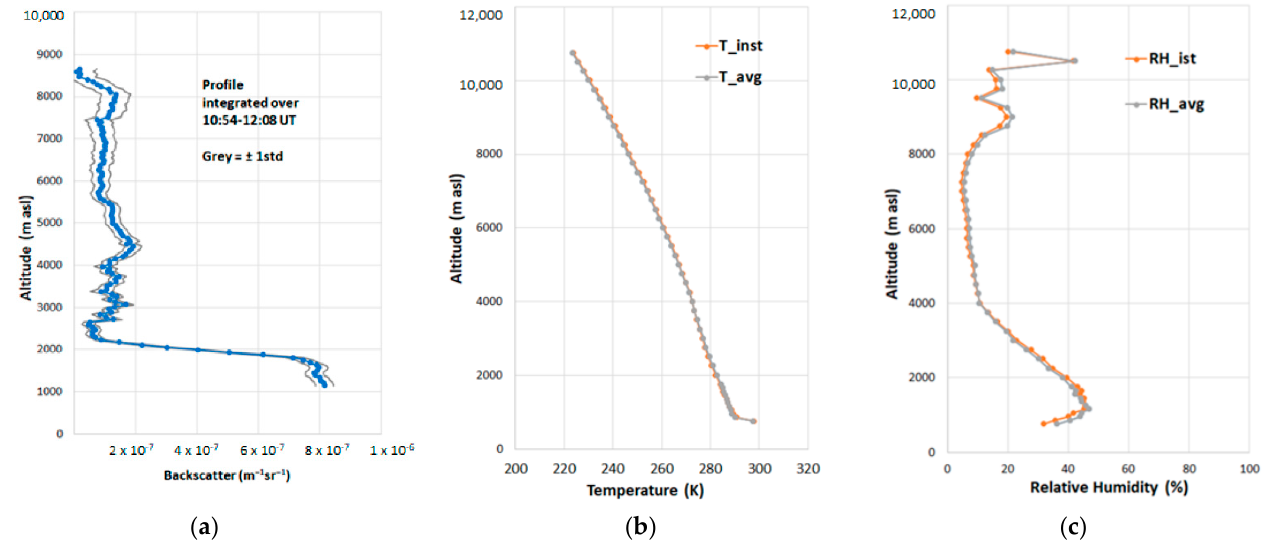
Figure 3. ( a ) Aerosol backscattering profile @550 nm, ( b ) temperature, and ( c ) water vapor profiles applied in the RT run to simulate the LTOA at the time of the PRISMA acquisition of 15 January